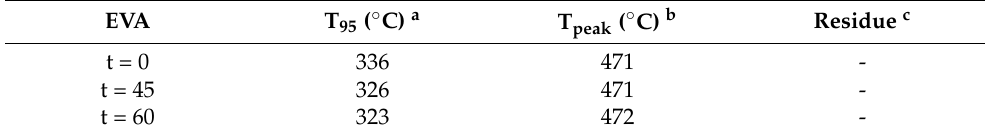
Table 1. Onset temperatures of degradation, temperatures at maximum rate of decomposition and residual masses of EVA at 0, 45 and 60 days of